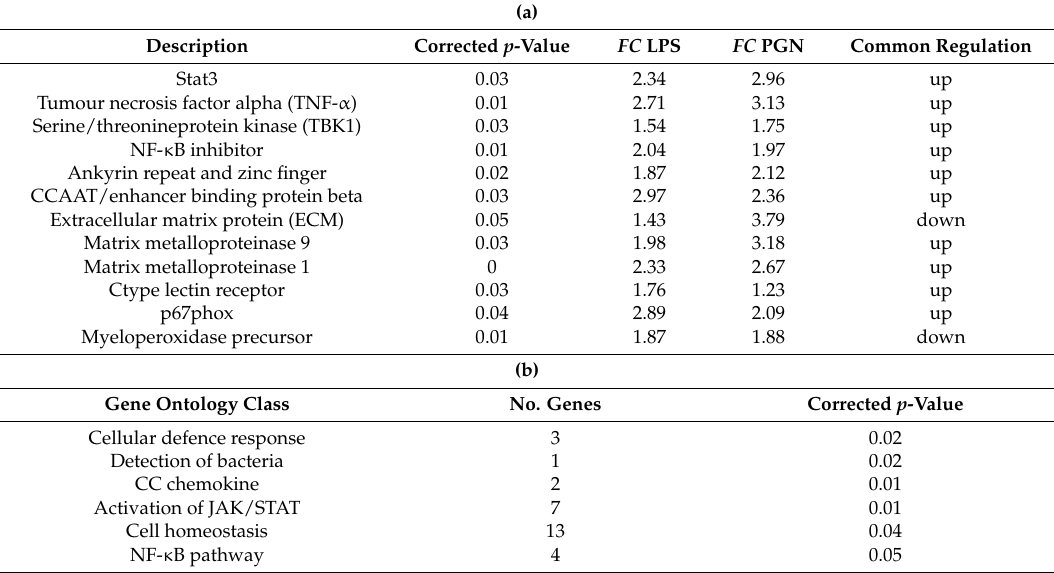
Table 2. ( a ) Common selected transcripts expressed in macrophages under LPS and PGN treatment; and ( b ) overexpressed GO categories ( p < 0.01) of the common macrophage transcripts expressed after treatments with PGN-LPS (No. Gene column shows the number of transcripts overexpressed in each GO category). FC, fold